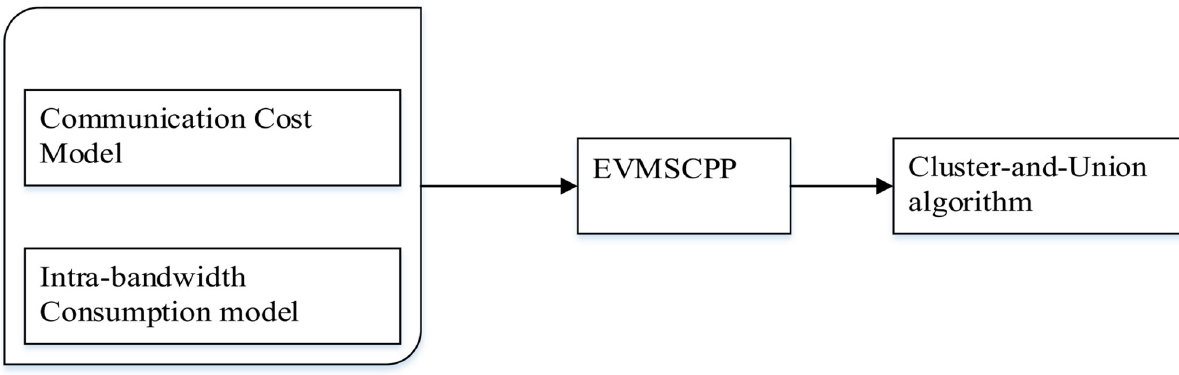
Fig 1. Model of the core